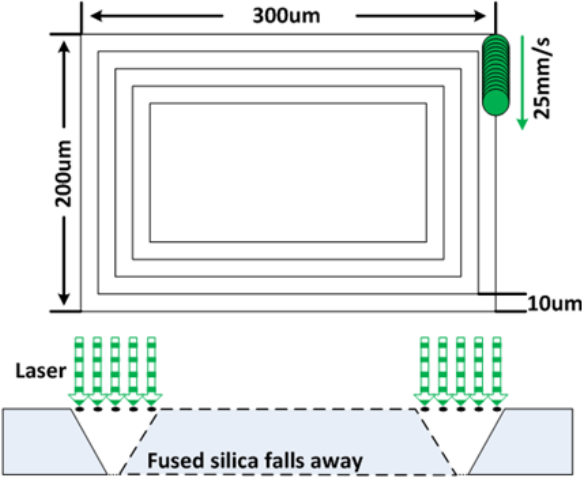
Figure 2. Methodology of laser ablating fused silica.